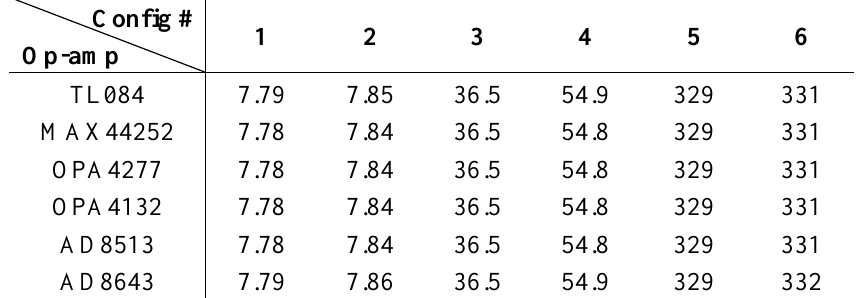
. On the left, configurations 1–6 o